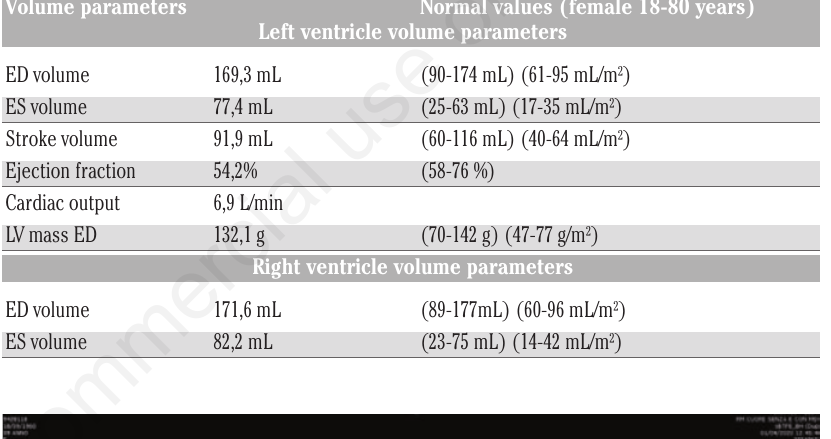
Table 1. Volume parameters at cardiac MRI (body surface area 2,18 m 2 ). Volume parameters